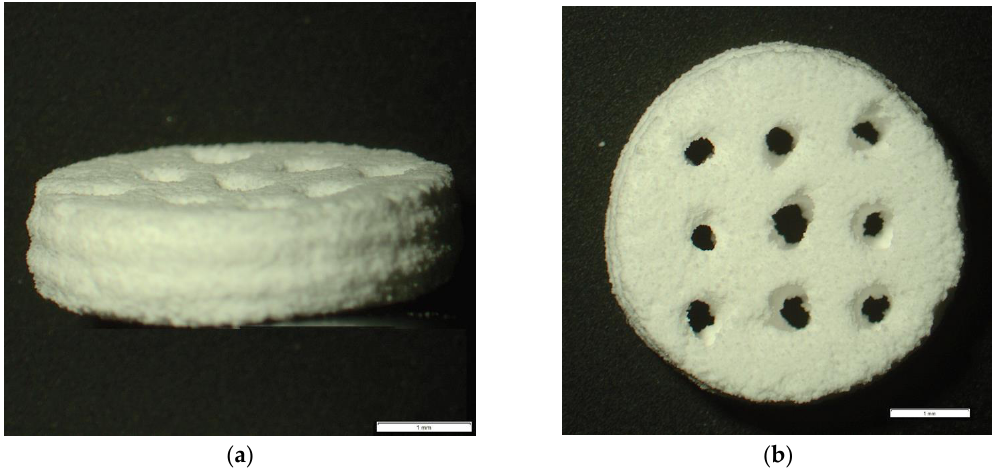
Figure 1. Side view ( a ); and top view ( b ) of 3D printed scaffold. The scale bar is 1 mm. Images were taken with Olympus (Tokyo, Japan) SZ-61. Table 1. Dimensions of 3D printed Samples ( n = 10).